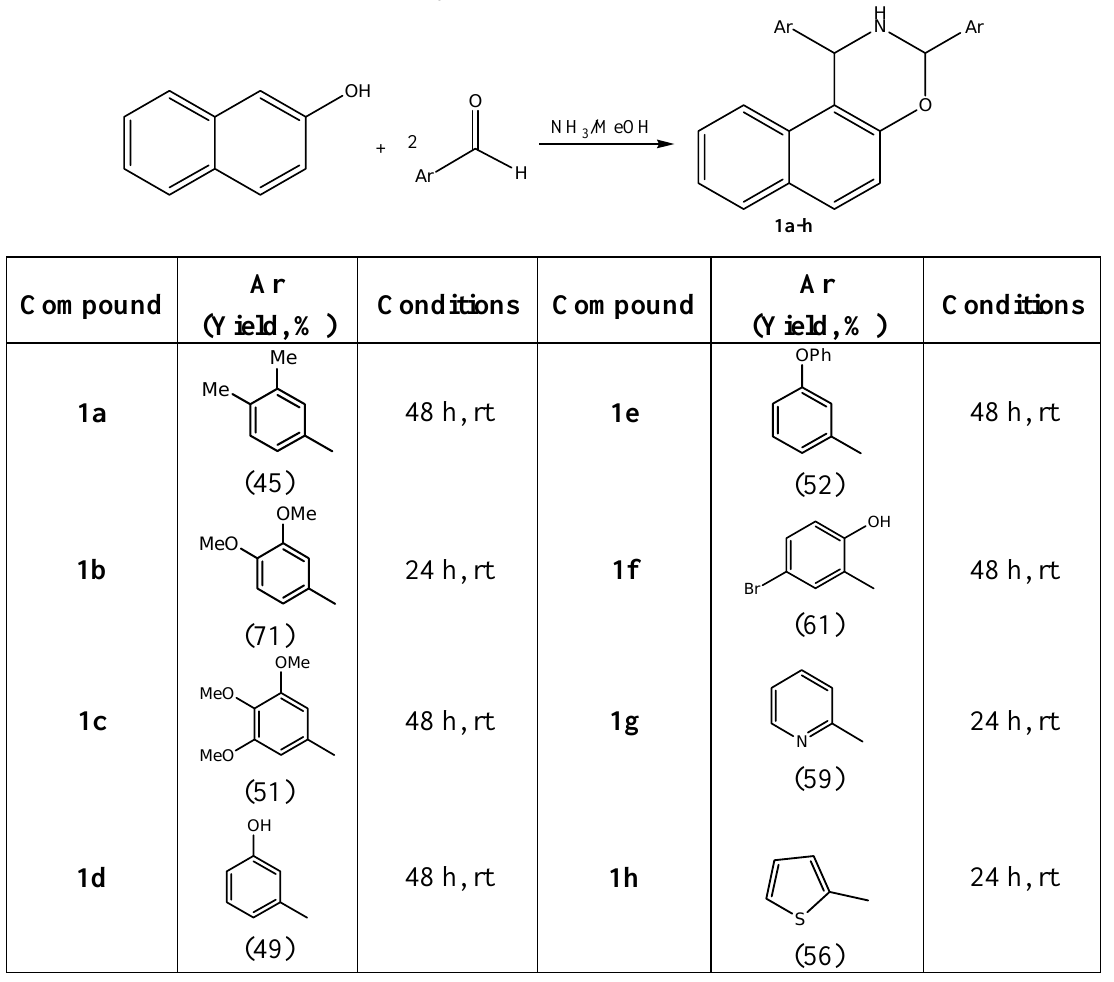
Table 1 . Synthesis of 1,3-oxazines 1a - h